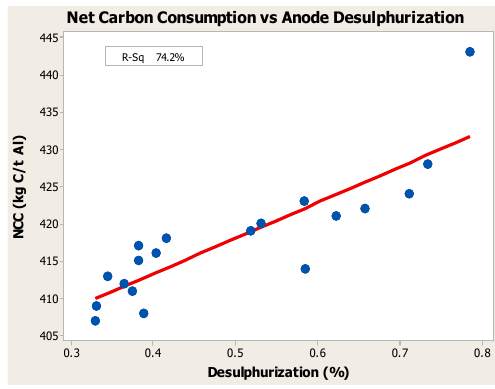
Figure 18. NCC vs. anode desulfurization.